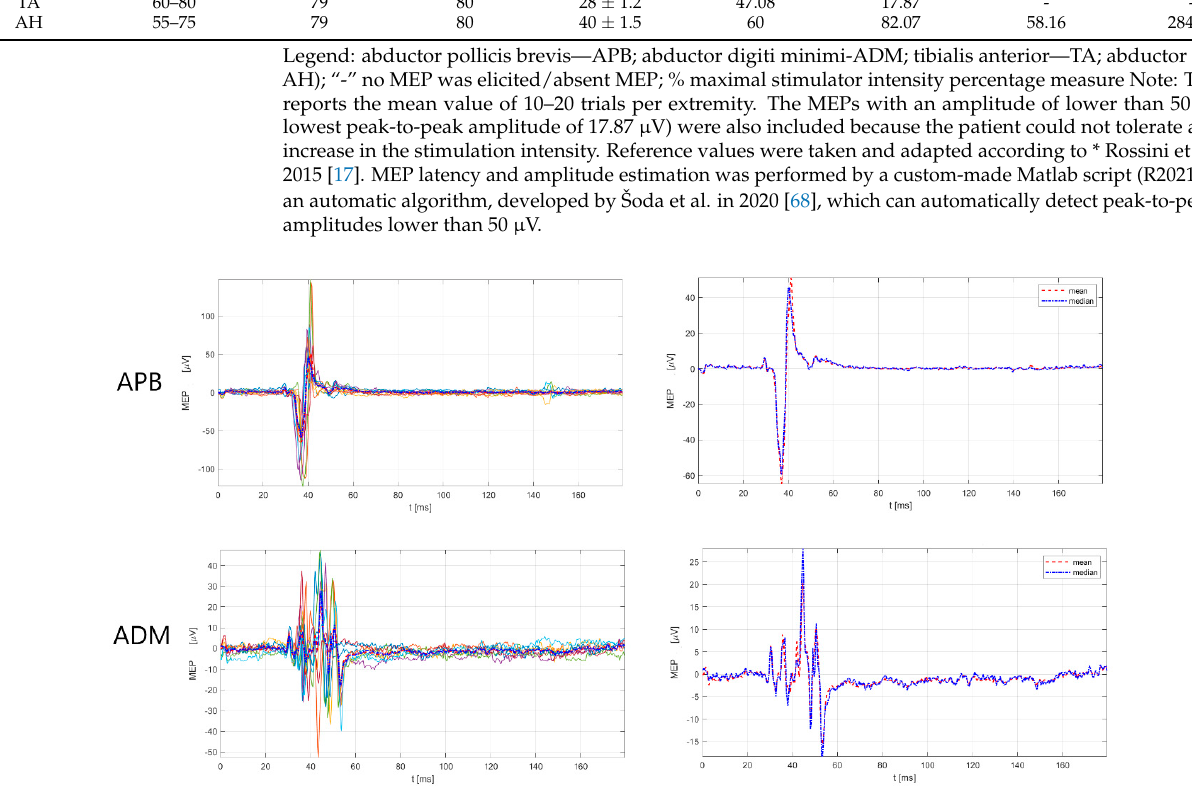
Table 2. Stimulation intensity, latency, and amplitude of MEP responses recorded from upper and lower limb muscles in No3.